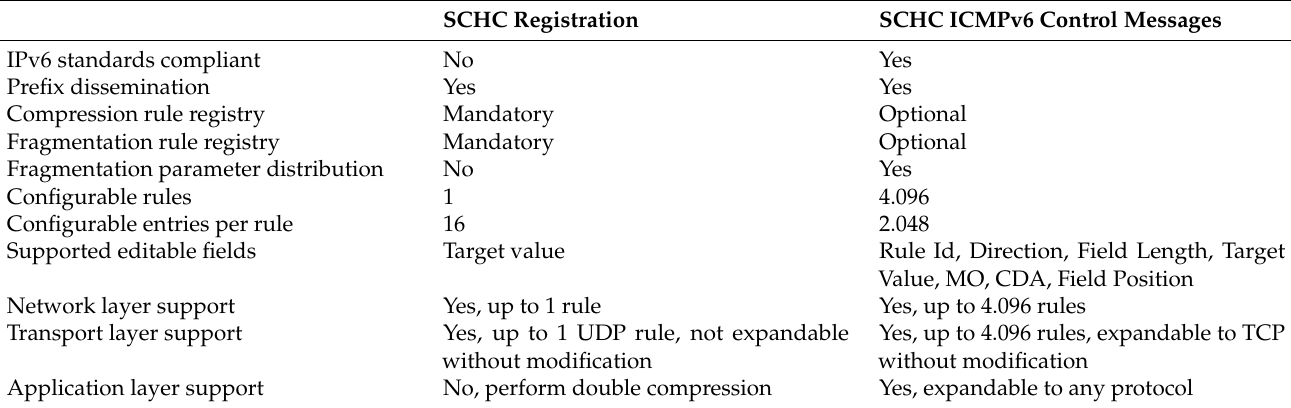
Table 2. Comparison of the SCHC Registration and ICMPv6 SCHC Control